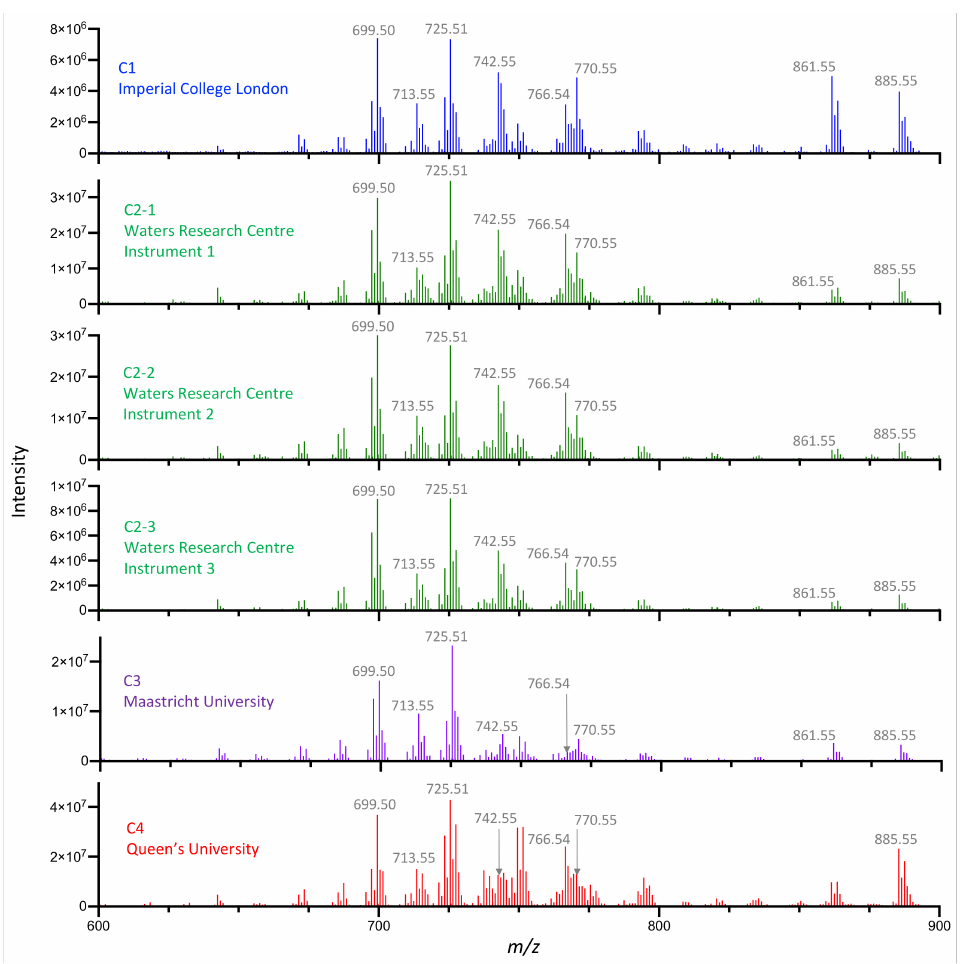
Figure 4. REIMS spectra of locally-sourced calf liver acquired at each center. Using harmonized analytical conditions, each site analyzed locally-sourced food-grade meats. Spectra from calf liver are presented, focusing on m/z range of 600–1000. For this study, C2 analyzed each sample on three different instruments. The representative spectra shown are the average of 6–7 individual